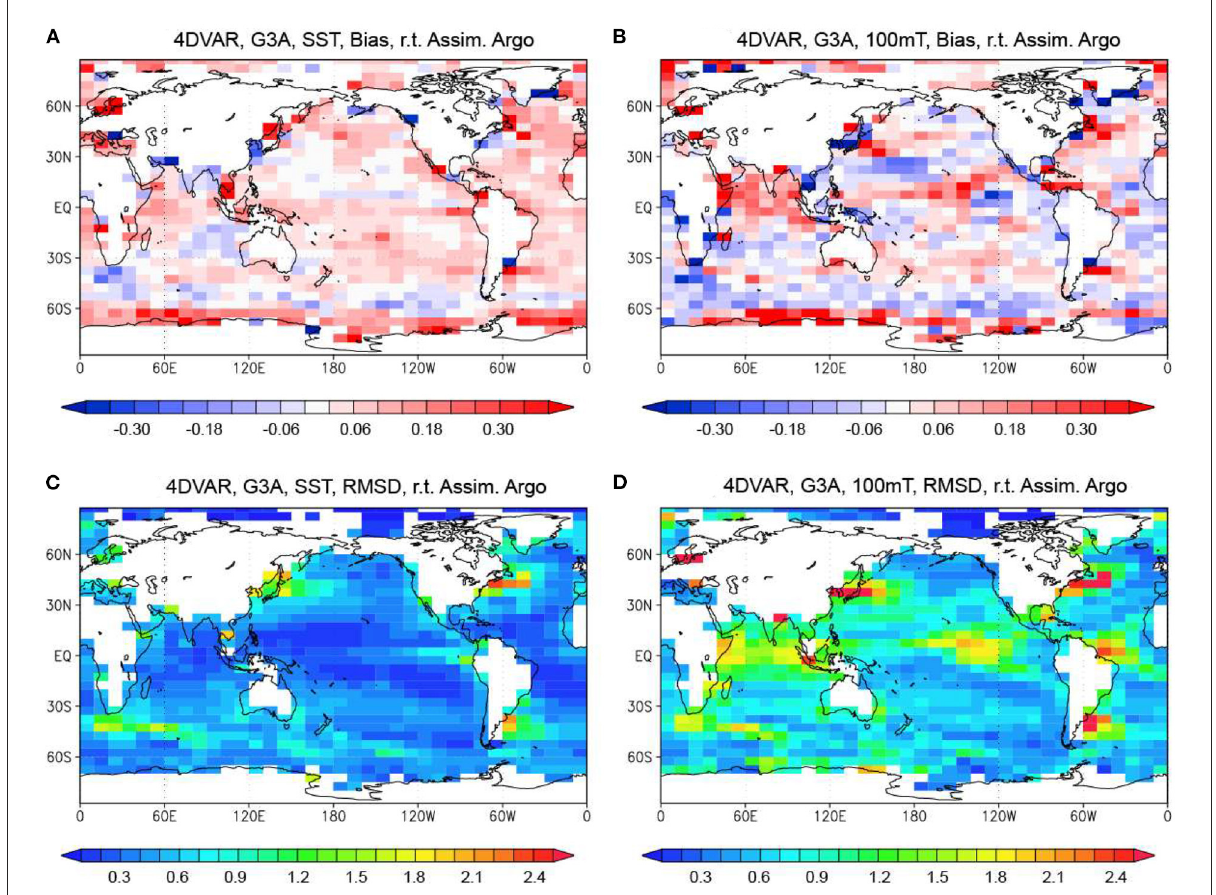
FIGURE4 Bias and RMSD of the MOVE-G3A temperature at the surface and 100m depth in for the 4DVAR Run relative to the assimilated Argo float data. (A, B) Bias at the surface and 100m depth. (C, D) RMSD at the surface and 100m depth. Units in ◦ C.